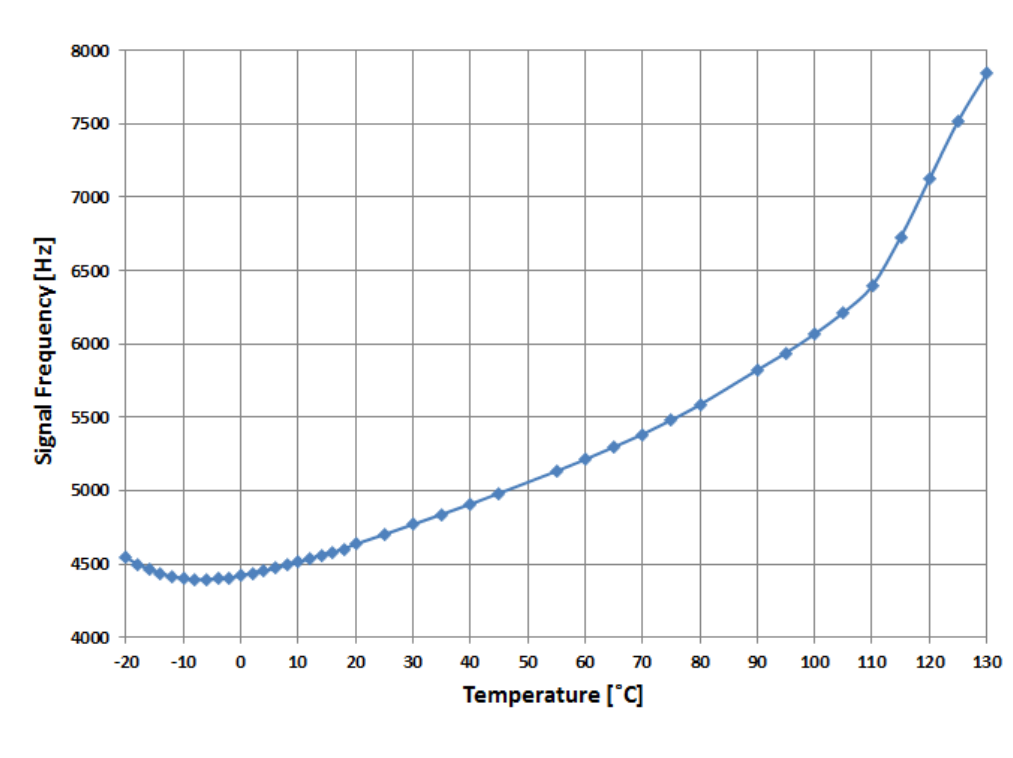
Figure 8. Output frequency variation as a function of temperature for an NLC cell (applied voltage of 6 V rms